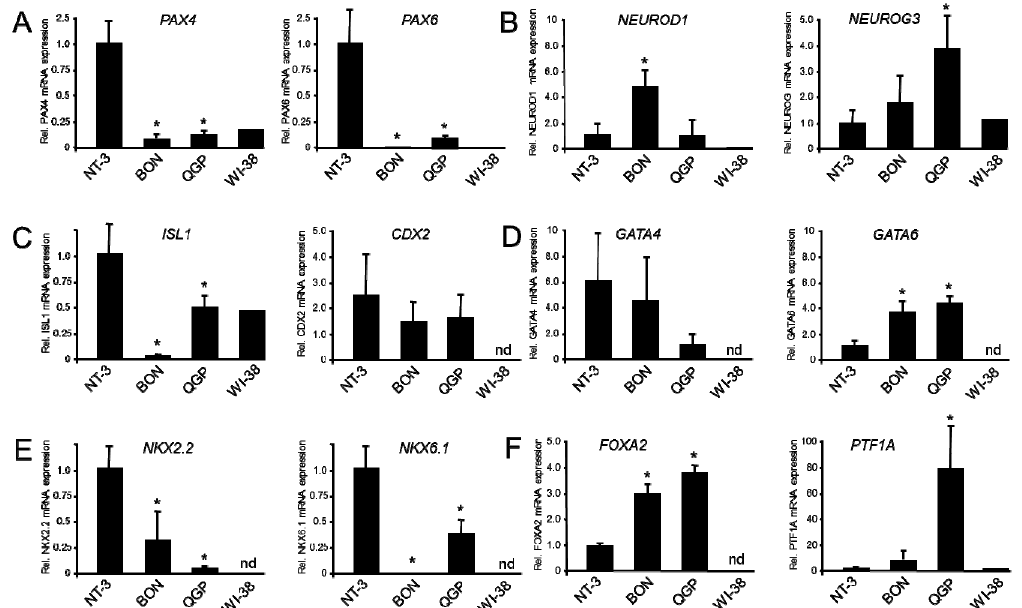
Figure 4. Quantitative real-time RT-PCR-based expression analysis of genes from immature β -cells and pancreatic (endocrine) progenitors in BON, QGP, and NT-3 cells. The indicated genes were grouped according to structural or functional similarities. ( A ) PAX4 and PAX6, ( B ) NEUROD1 and NEUROG3, ( C ) ISL1 and CDX2, ( D ) GATA4 and GATA6, ( E ) NKX2.2 and NKX6.1, ( F ) FOXA2 and PTF1A. Data represent the mean ± SD from three to four preparations. The asterisks ( ∗ ) indicate significant differences relative to NT-3 cells ( p < 0.05, Wilcoxon test), nd, not determined. ISL1, a TF binding to INS enhancer sequences, is 43-fold lower in BON compared to NT-3 cells (Figure 4C). In contrast, CDX2 which by synergistic interactions with PAX6 can activate gene transcription of GCG (Figure 4C), GATA4, a TF expressed during early pancreatic budding, and GATA6 were either equally expressed in BON, QGP and NT-3 (CDX2, GATA4) or were even higher in BON and QGP compared to NT-3 cells (GATA6). The mRNA abundance of NKX2.2, a TF important for development of α -, β -, and δ -cells and for maintenance of β -cell identity, is 3-fold lower in BON and 30-fold lower in QGP than in NT-3 cells (Figure 4E), while NKX6.1, which is crucial for islet endocrine cell development and insulin secretion in β -cells, is 3-fold lower in QGP and 1500-fold lower in BON cells (Figure 4E). HNF3 β /FOXA2 is a TF expressed in foregut endoderm which differentiates into pancreatic buds. Its expression continues in all pancreatic cell types and during pancreatic development and peaks in pancreatic islets where it is important for the development and functionality of β -cells. Interestingly, FOXA2 transcript levels are 3–4-fold higher in both BON and QGP compared to NT-3 cells (Figure 4F). PTF1A , a gene that plays a role in determining whether cells allocated to the pancreatic buds continue towards pancreatic organogenesis or revert to duodenal fates, has its strongest expression in QGP cells, being 70-fold higher and in BON 6.5-fold higher than in NT-3 cells (Figure 4F). The data from the developmental gene expression survey clearly show that BON and QGP cells have higher expression of genes involved in pancreatic and early but not late endocrine differentiation of the pancreas. 2.5. Identification of MiRs Expressed in BON and QGP Cells MiRs are involved in various aspects of cellular function, normal pancreas development, islet differentiation, or pancreatic tumorigenesis [18], and represent potential prognostic markers in NET [19]. For identification of miRs we subjected total RNA samples of untreated BON, QGP, and NT-3 cells to next-generation sequencing (NGS) analysis. We were able to identify a total of 43 miRs in BON and 50 miRs in QGP cells, of which 15 and 12 miRs, respectively, were novel and previously